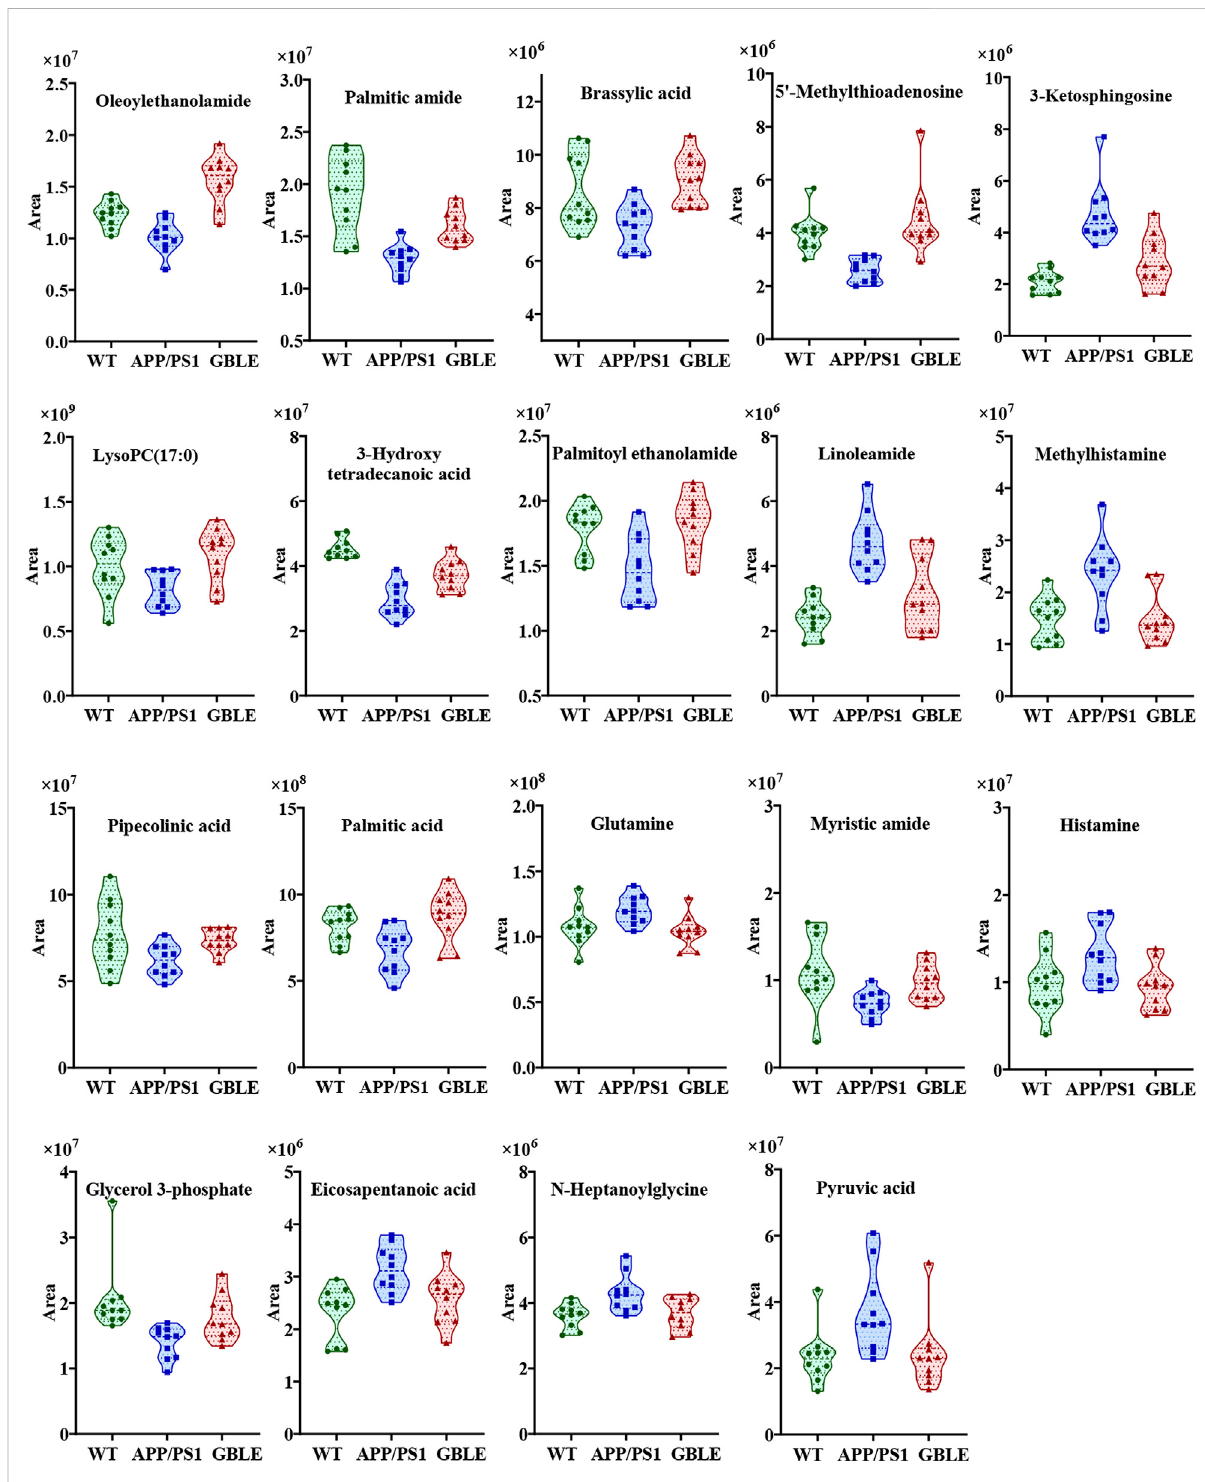
Violin plots showing the average peak area changes of each metabolite signi fi cantly ameliorated by